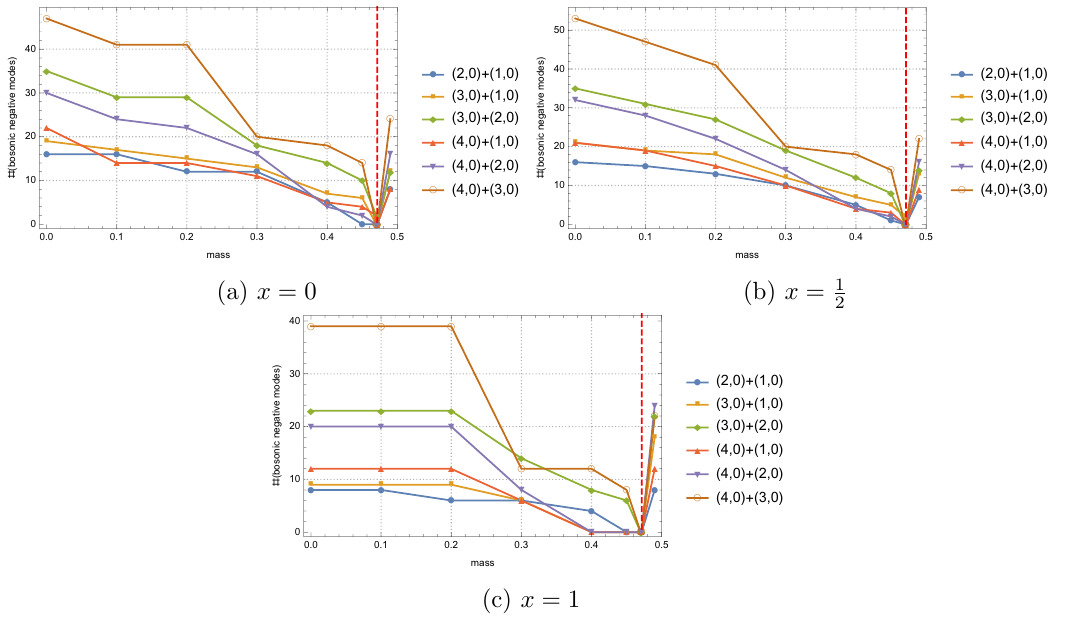
Figure 28. C [( N 1 ; 0)] + C [( N 2 ; 0)] with Higgs con(cid:12)guration (B.15). We display the number of negative modes in the spectrum of O X + (cid:30) in (a){(c). The red dashed vertical lines indicates the p mass value M (cid:3) = 2 =